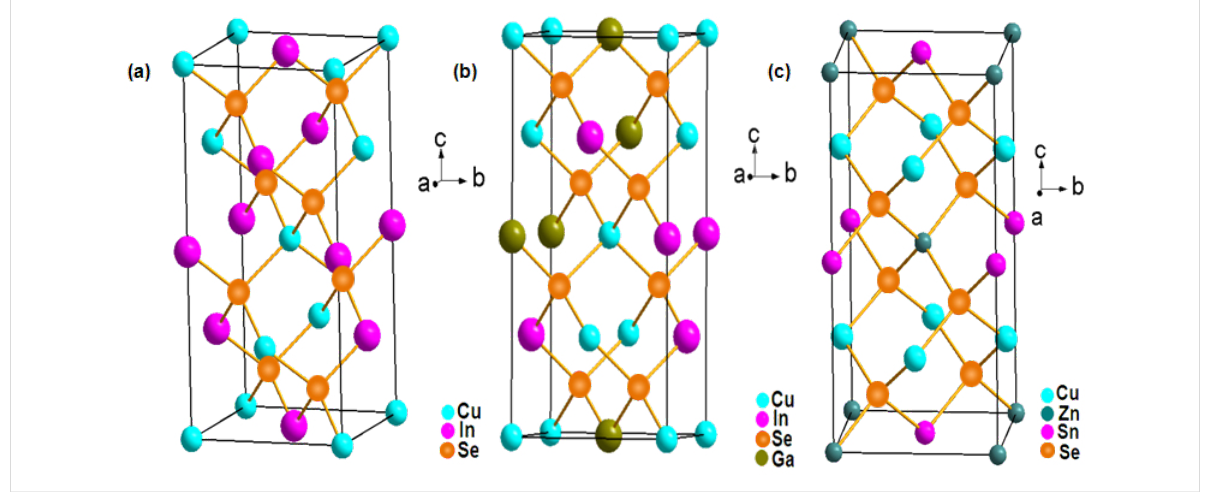
Figure 1: The crystal structures of (a) CISe, (b) CIGSe and (c) CZTSe.